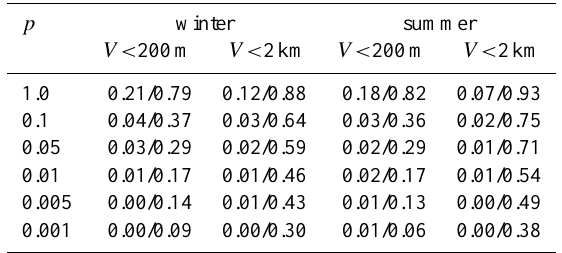
Table 1. Fraction of the 329 stations with positive/negative trends in days with low visibility that are significant at the p -values in the first column.